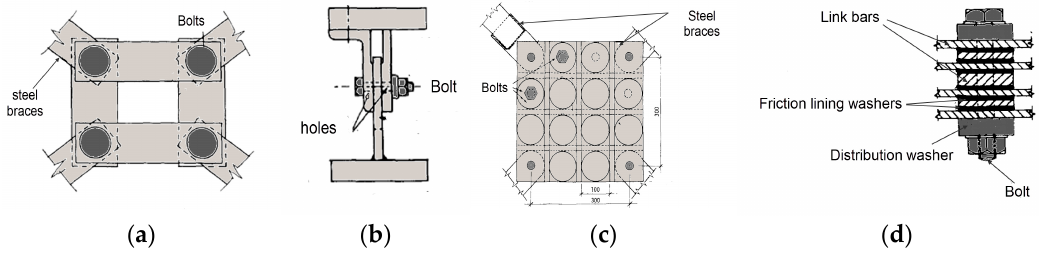
Figure 4. Improvement of PFD proposed by Anagnostides et al.: 1. three plates damper with high-strength bolts ( a ) longitudinal section, ( b ) cross-section. 2. twelve friction joints incorporating frictional washers ( c ) longitudinal section, ( d ) cross-section.